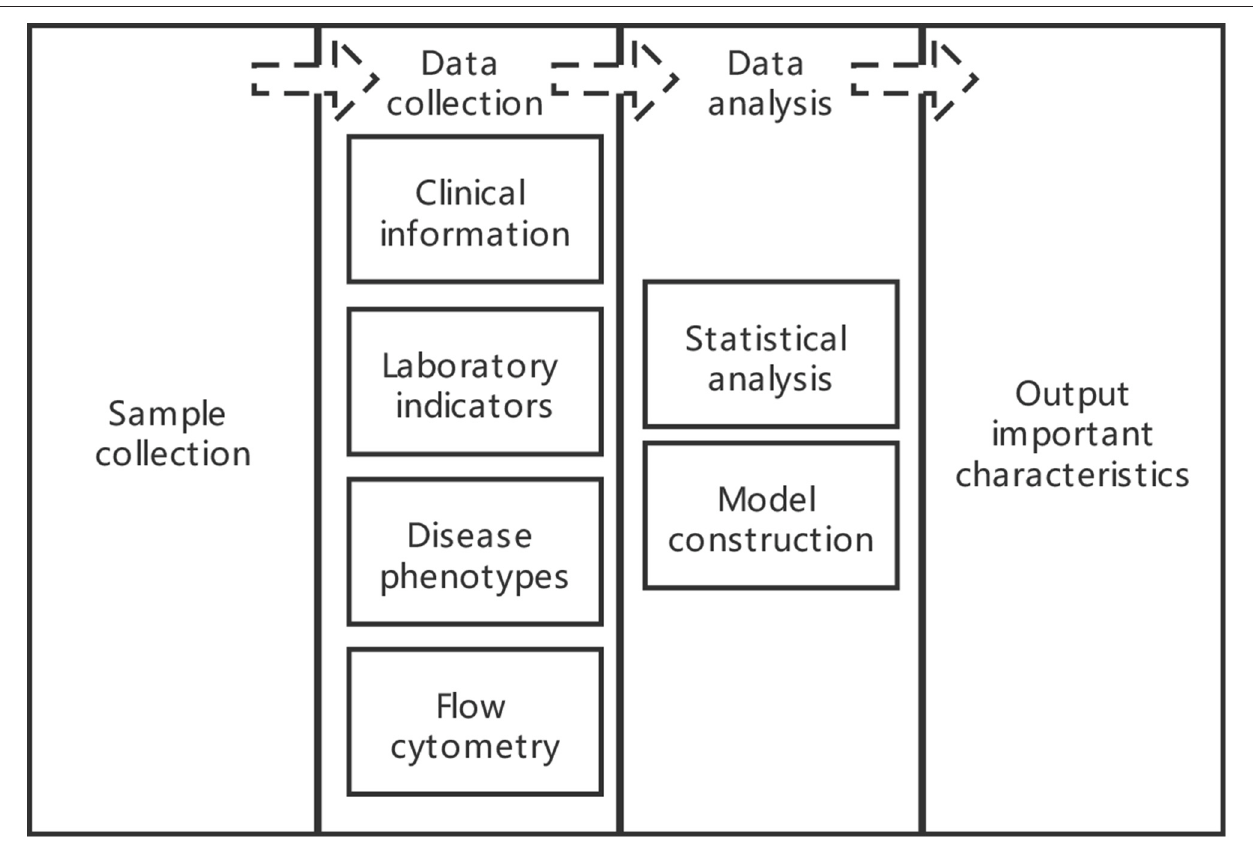
FIGURE 1 | Study design and analysis plan flow